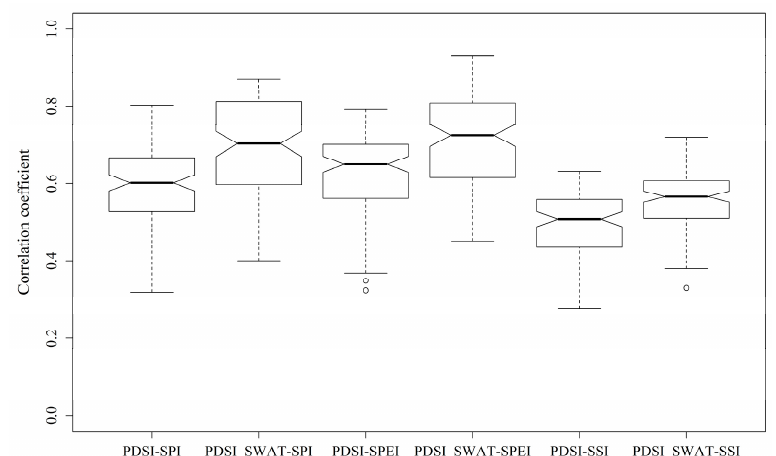
Figure 5. The boxplot of the correlation coefficient of 113 sub-basins between PDSI/PDSI_SWAT and other meteorological and agricultural drought indices during 1961–2012. The whiskers are the maximum and minimum values of the distributions, the box boundaries are the first and third quartiles, and the point within the box is the second quartile (median).